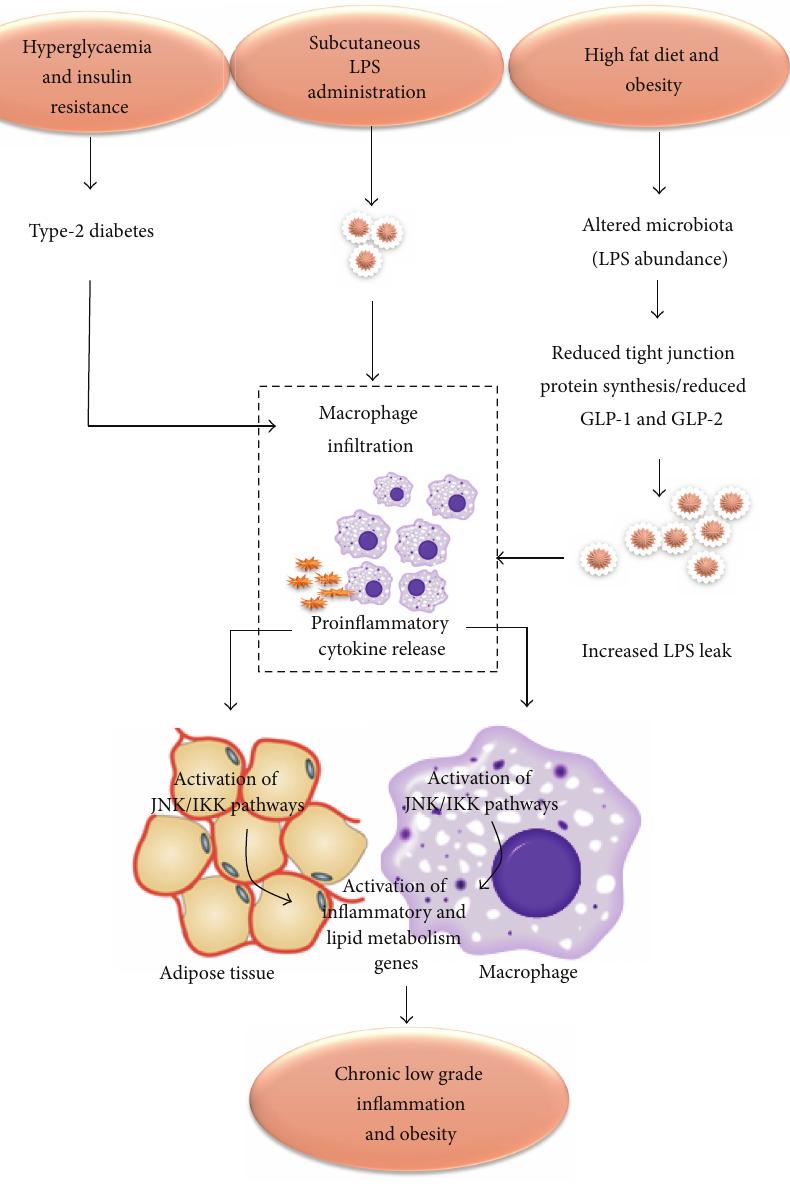
Figure 3: Proposed model for the role of LPS in generating inflammation and its relationship with obesity. Concept adapted from [9– 12]. Altered mucosal barrier function due to reduced expression of glucagon like peptides 1 and 2 (GLP-1 and GLP-2) leads to altered mucosal function and reduced synthesis of tight junction proteins, Zonula Occludin-1 and Zonula Occludin-2 (ZO-1, ZO-2), increasing gut permeability. This allows LPS to enter the systemic circulation inducing the release of proinflammatory cytokines. Proinflammatory cytokines result in activation of a family of kinases JNK and IKK (inhibitor of NFkB kinase) that increase the expression of inflammatory and lipid metabolism genes. Subcutaneous administration of LPS, hyperglycaemia, and insulin resistance induces the same pathway by increasing the endoplasmic reticulum and mitochondrial stress. Type-2 diabetes, hyperglycaemia, and insulin resistance also cause macrophage infiltration and inflammatory cytokine release leading to the same process. HF: high fat diet